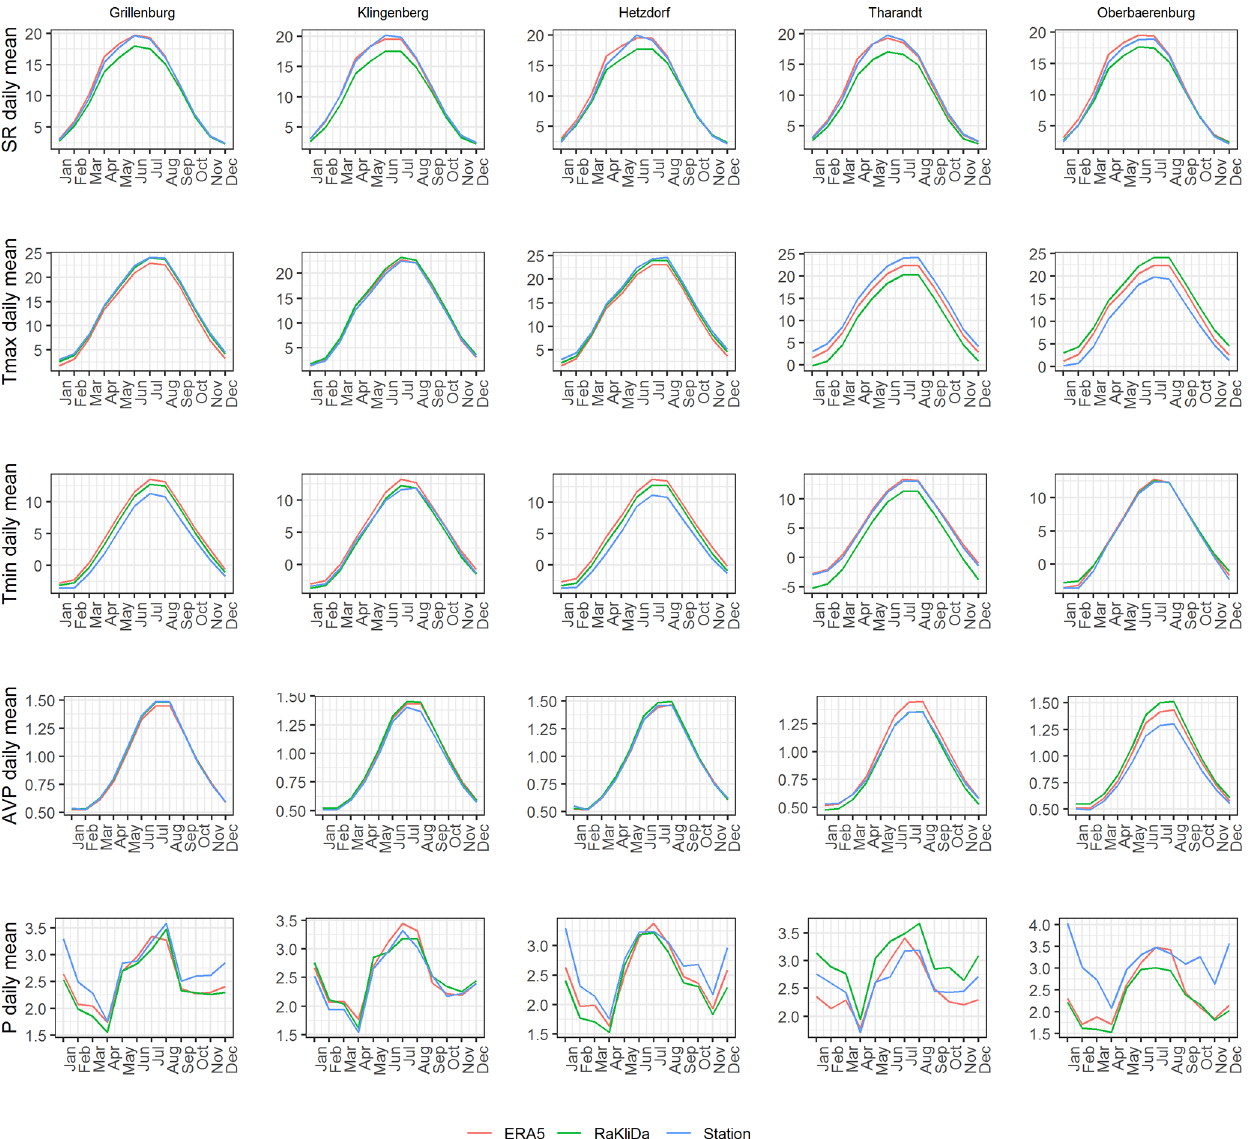
Figure A1. Monthly daily mean meteorological